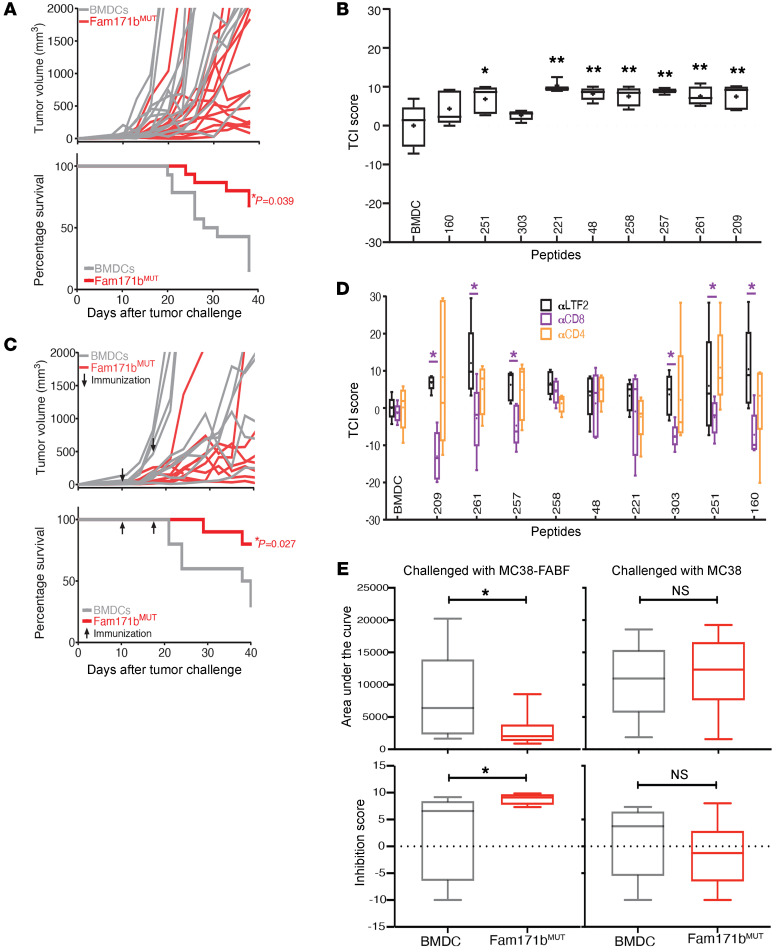
Characterization of the activity of TRMNs.(A) Tumor growth curves (top) and percentage survival (bottom) of mice immunized prophylactically with FAM171bMUT (red) or unpulsed BMDCs (gray). Each line shows tumor volume for 1 mouse. The experiment was done 2 times (n = 10 and n = 5). (B) TCI scores of mice treated with each of the 9 TRMNs on days 0 and 7 after tumor challenge. n = 10 mice/group. The experiment was done twice. (C) Tumor growth curves (top) and percentage survival (bottom) of mice treated on days 10 and 17 after tumor challenge (indicated by arrows) with FAM171bMUT (red) or unpulsed BMDC (gray), n = 10 mice/group. The experiment was done twice. (D) TCI scores of mice immunized with the 9 TRMNs and depleted of CD8+ (purple) or CD4+ cells (orange) or treated with an isotype control antibody (αLTF2) (black). The experiment was done twice. n = 5 mice/group. (E) Mice (n = 15) were immunized with unpulsed or FAM171bMUT-pulsed BMDCs. Five days later, CD8+ cells were isolated from the inguinal and popliteal lymph nodes. Two million CD8+ T cells were adoptively transferred into 9 mice/group. Mice were challenged with MC38-FABF on the right flank and MC38 on the left flank. Tumor growth was monitored. Data represent area under the curve (top) and growth inhibition (bottom) in mice that received T cell transfers from unpulsed BMDC-immunized mice (gray) or FAM171bMUT-immunized mice (red). *P < 0.05; **P < 0.01 by log-rank (Mantel-Cox) test (survival plots in A and C), Student’s t test (B and E), or 2-way ANOVA with Tukey’s multiple-comparison test (D). Box-and-whisker plots were generated as in Figure 1.